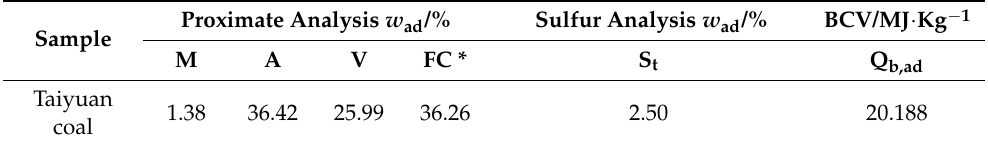
Table 1. Proximate and heating value analysis of samples. Proximate Analysis w ad /% Sulfur Analysis w ad Sample